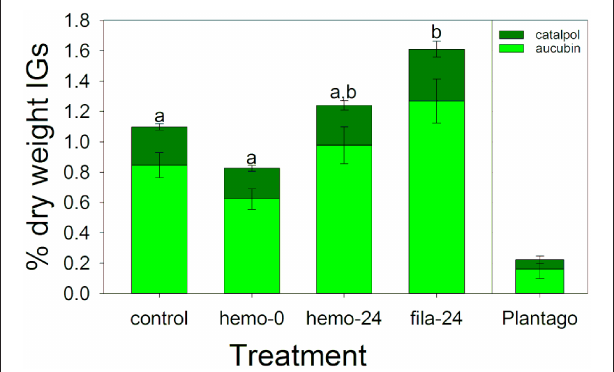
FIGURE 5 | Iridoid glycoside sequestration during the March experiment testing the effects of immune challenge showed no significant difference in the proportion catalpol sequestered. However, total IG sequestration was similar between controls and caterpillars where hemolymph was sampled, but increase when immune challenged with a nylon filament. Letters are significant groups from a Tukey post-hoc test of % dry weight IGs. Bars represent ± 1